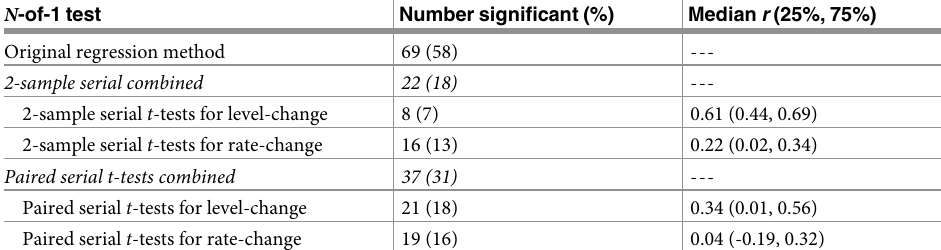
Table 6. Number (percent) of 119† patients discounting differently between pre- and